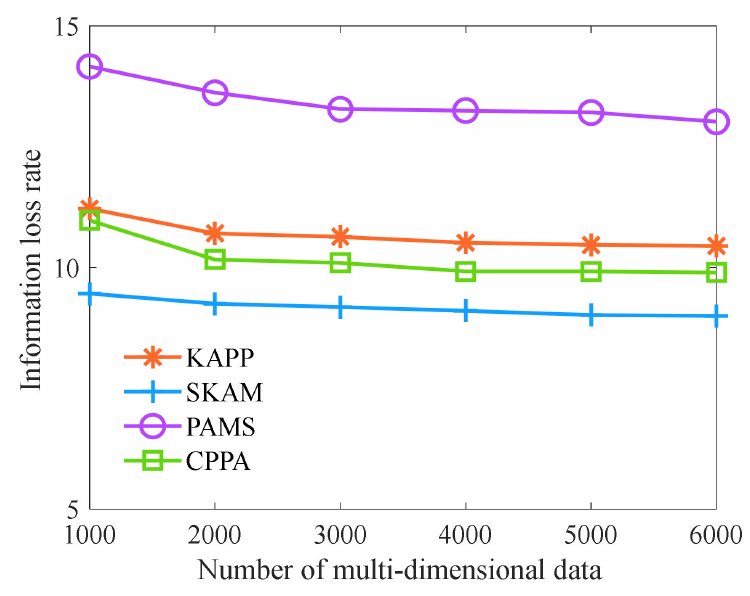
Figure 8. Comparison of information loss